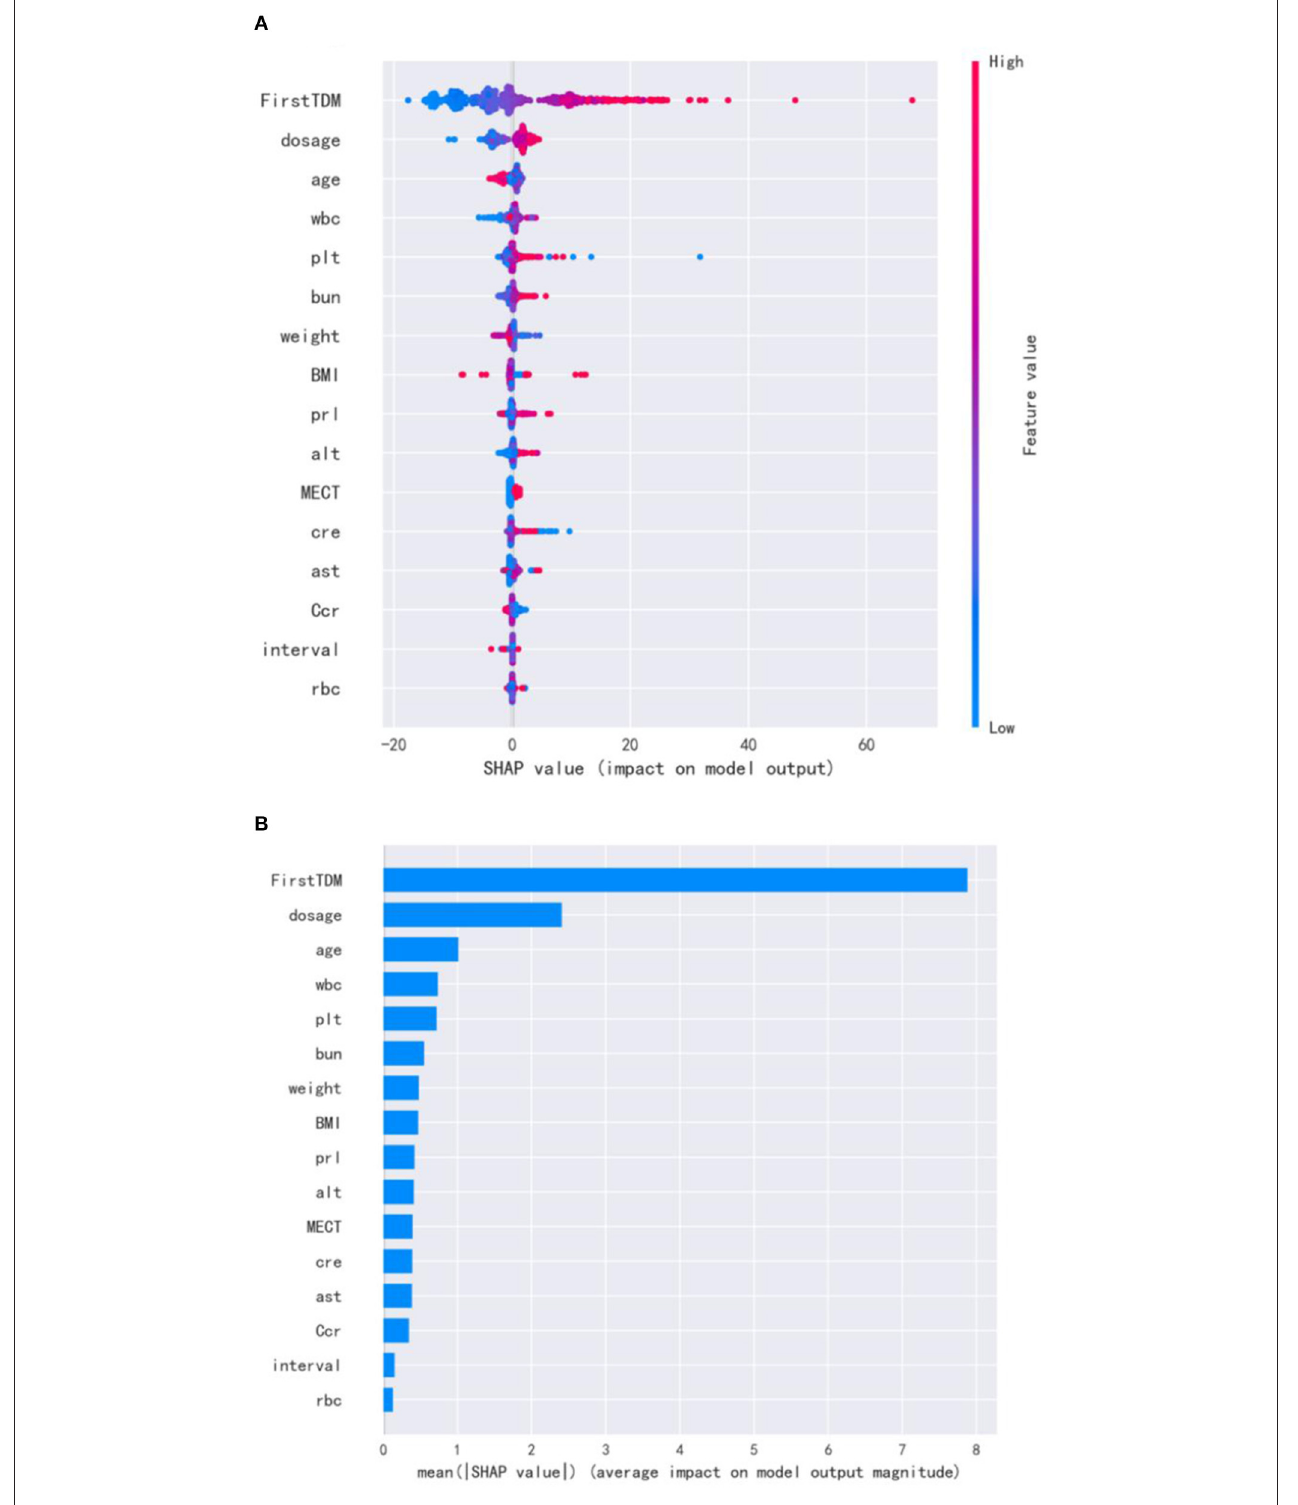
FIGURE 2 | SHAP for important variables affecting the next risperidone TDM. (A) visualization of the variable impacts. The dot color is redder when the feature value gets higher and bluer when the feature value gets lower. When the SHAP value gets higher, the impact of the variable on model output is larger. (B) Ranking of the mean absolute SHAP values. The larger mean absolute SHAP value indicates the stronger